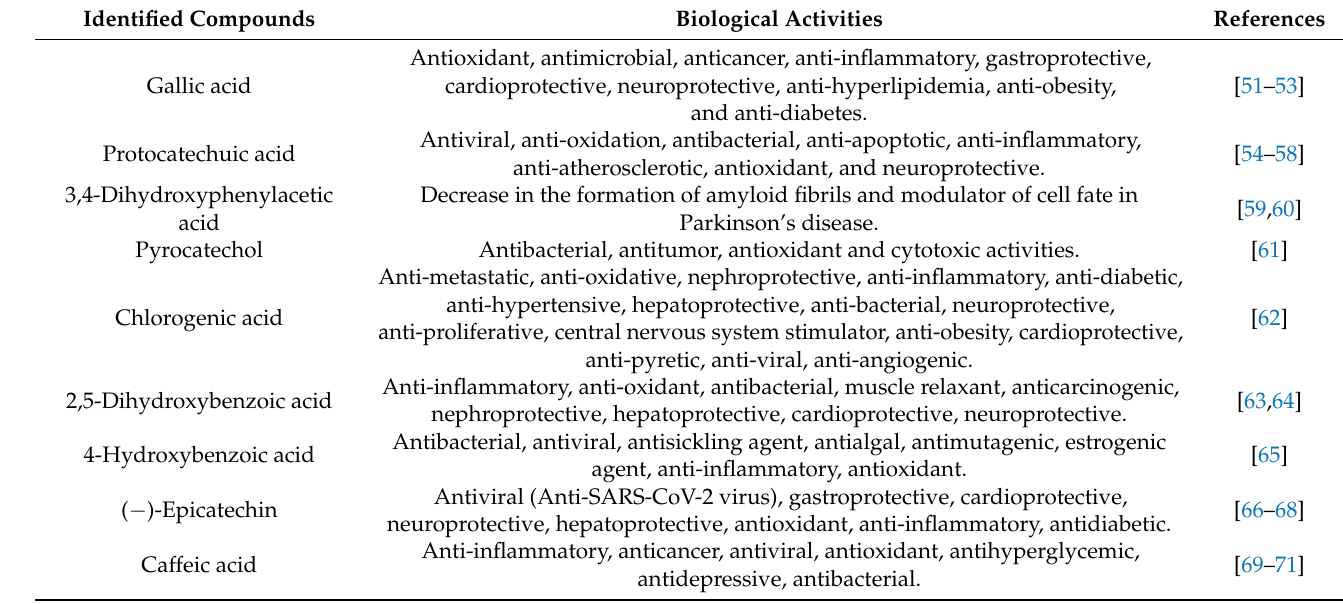
Table 6. Literature survey showing some biological activities of the identified molecules in D. flabellifolia hydroalcoholic